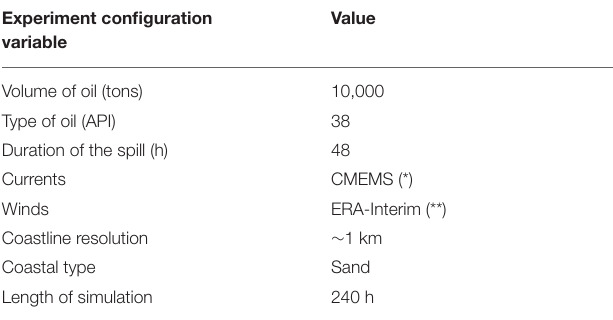
TABLE 1 | Configuration of the ensemble experiments for the three areas of the Eastern Atlantic archipelago, the Western Atlantic Island and the Brazilian state of